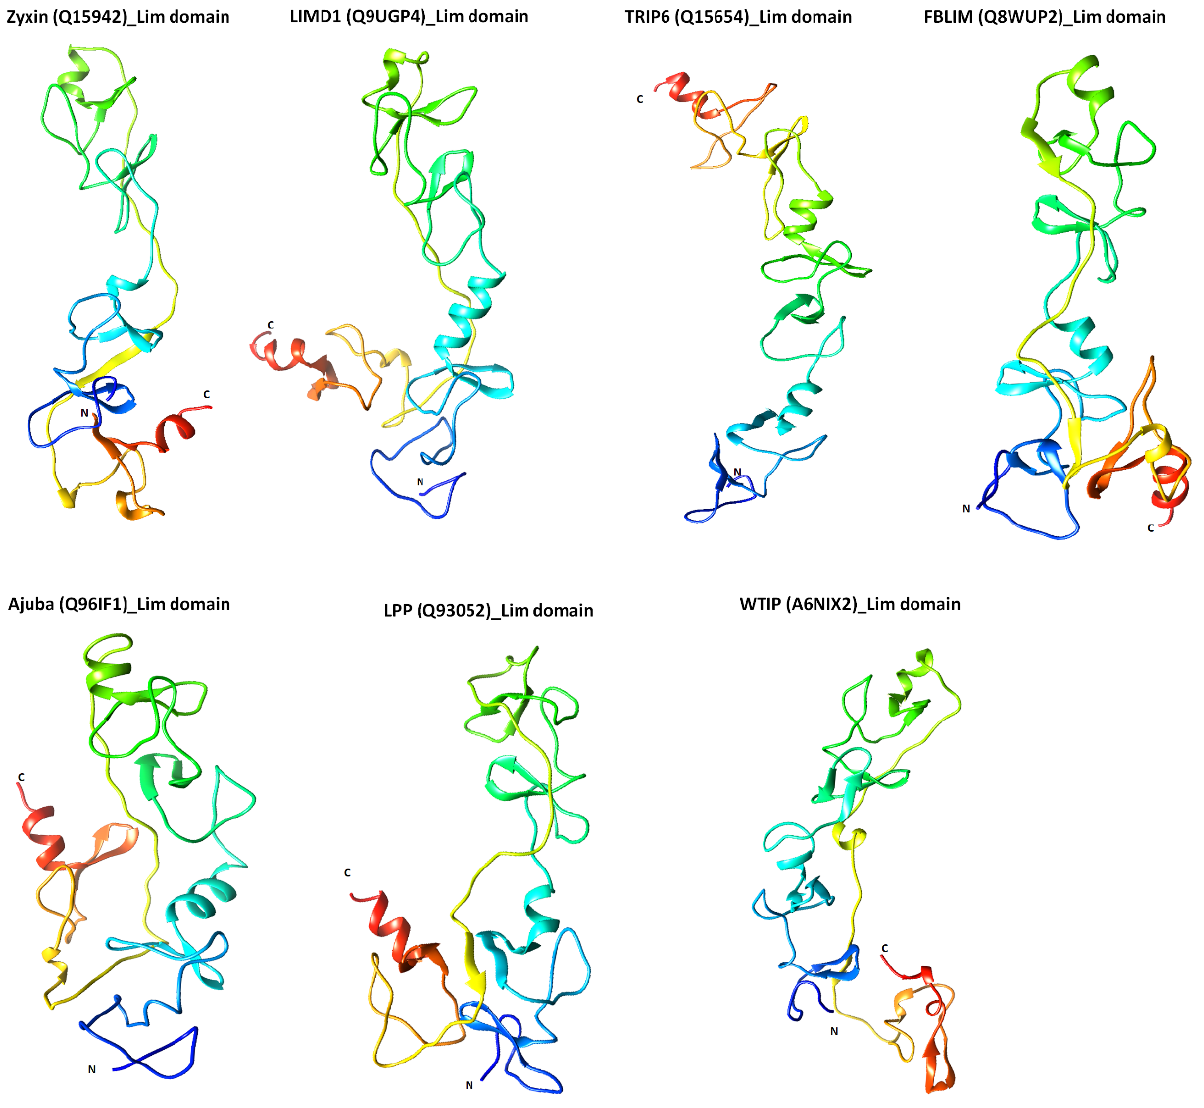
Figure 3. Structures of Lim domains of the Zyxin family proteins. The structures were generated using comparative/homology modeling in Robetta server. Robetta server generates structure using structures identified by BLAST and PSI-BLAST using PDB database, the regions of the protein that could not be modeled using BLAST are modeled de-novo using Rosetta fragment insertion method. For each model, the N- and C-terminal are depicted in blue and red, respectively. All models were validated using PROCHECK and SWISS-MODEL workspace; and the structures with the highest Z-score are presented in Supplementary Figure 4.